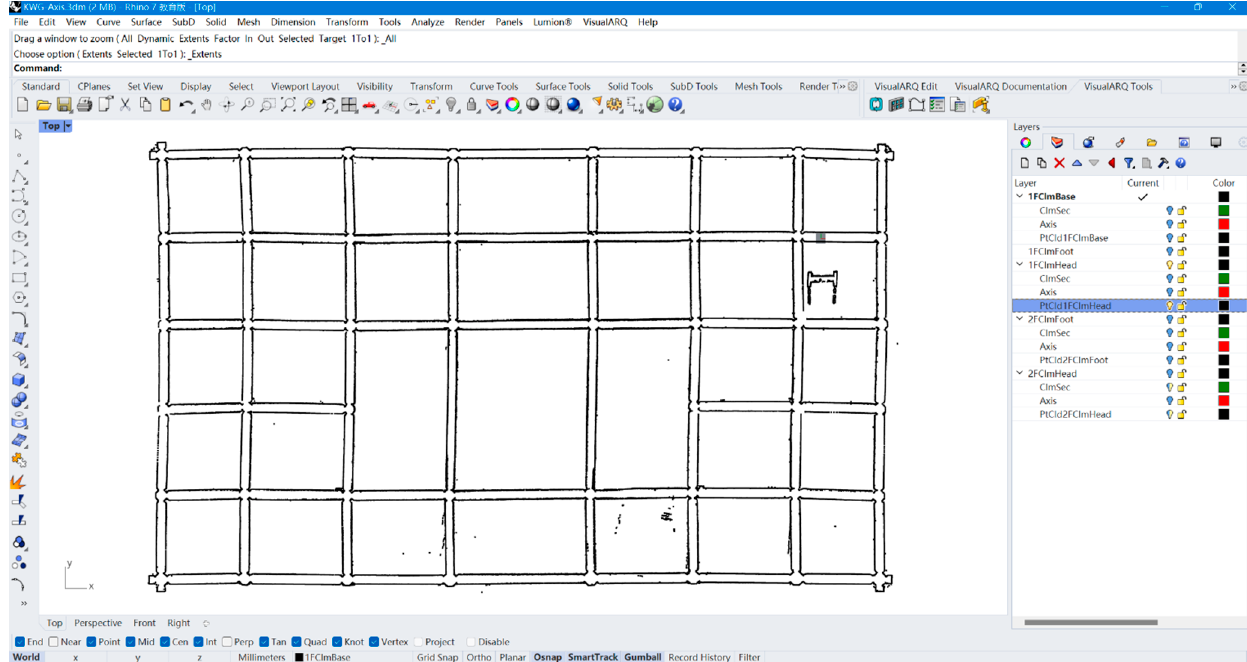
Figure 2. A plane section of column heads from the point cloud shows an irregular grid system.